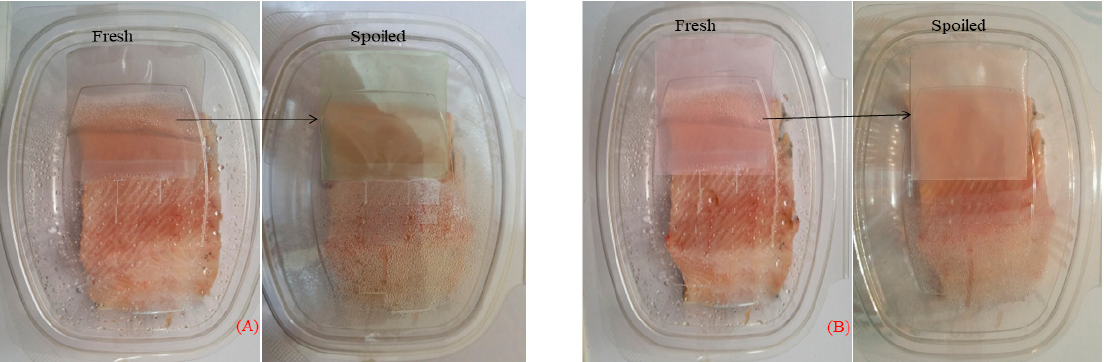
Figure 8. Monitoring the freshness/spoilage of fish fillets using the pH-sensitive smart indicator during storage at RT: ( A ) G/ChNFs/SPAs and ( B ) G/ChNFs/BAs.